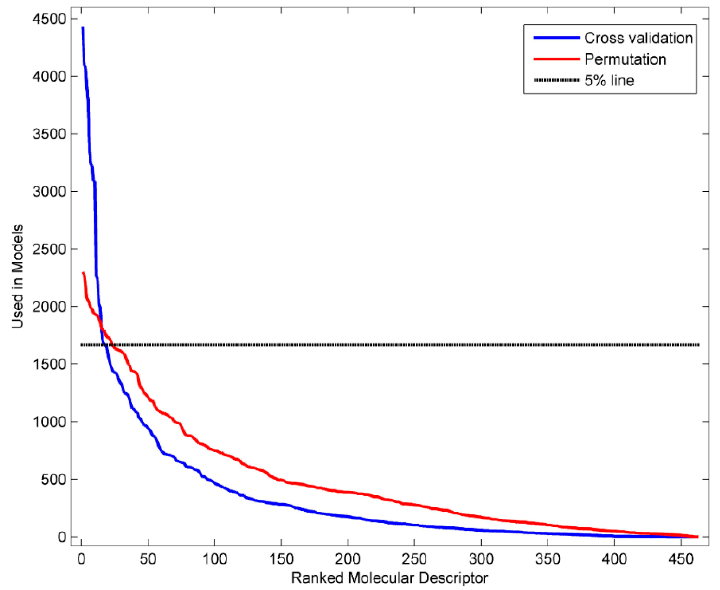
Figure 5. The distribution of descriptors used in the DF models.